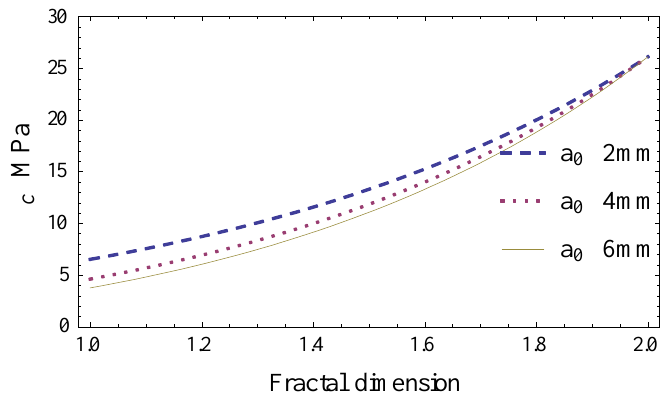
Figure 16. The relationship between σ c and d f